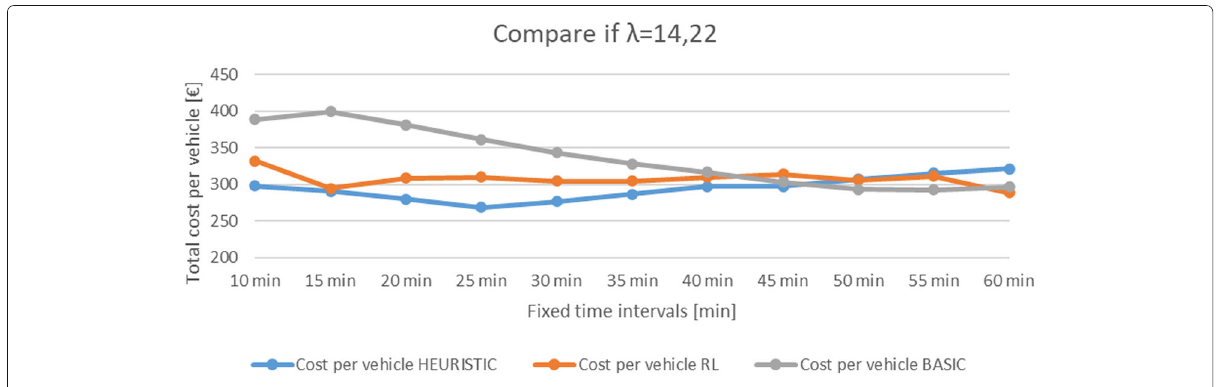
Fig. 9 Compare the 3 models if λ is 14,22 min